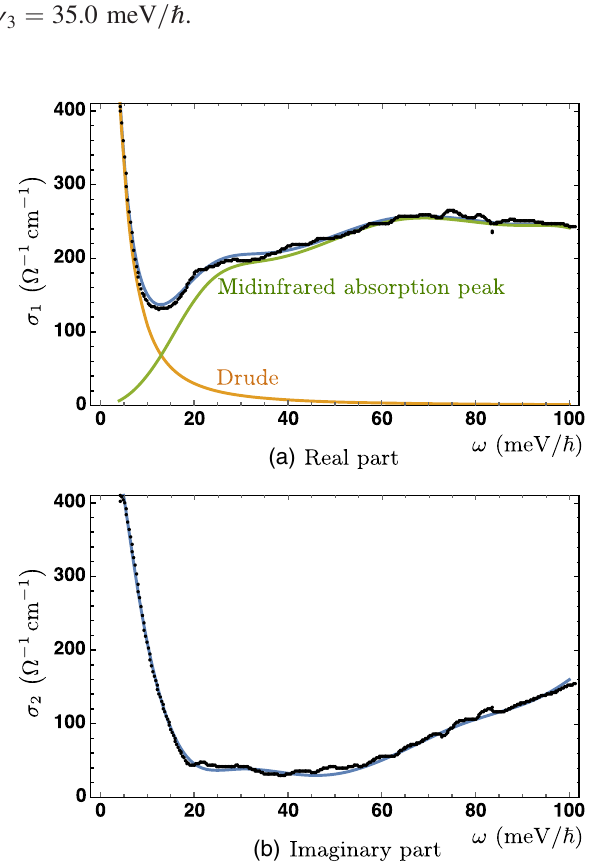
FIG. 9. Optical conductivity of the normal state at equilibrium. Black dots: measured conductivity. Blue curve: fit to a sum of Drude and Lorentzian peaks, Eq. (E1). Orange and green curves: contributions to σ 1 arising from the Drude peak and Lorentzian peaks, respectively. The Lorentzian peaks represent a broad midinfrared absorption peak, which we assume, for simplicity, not to be affected by the onset of